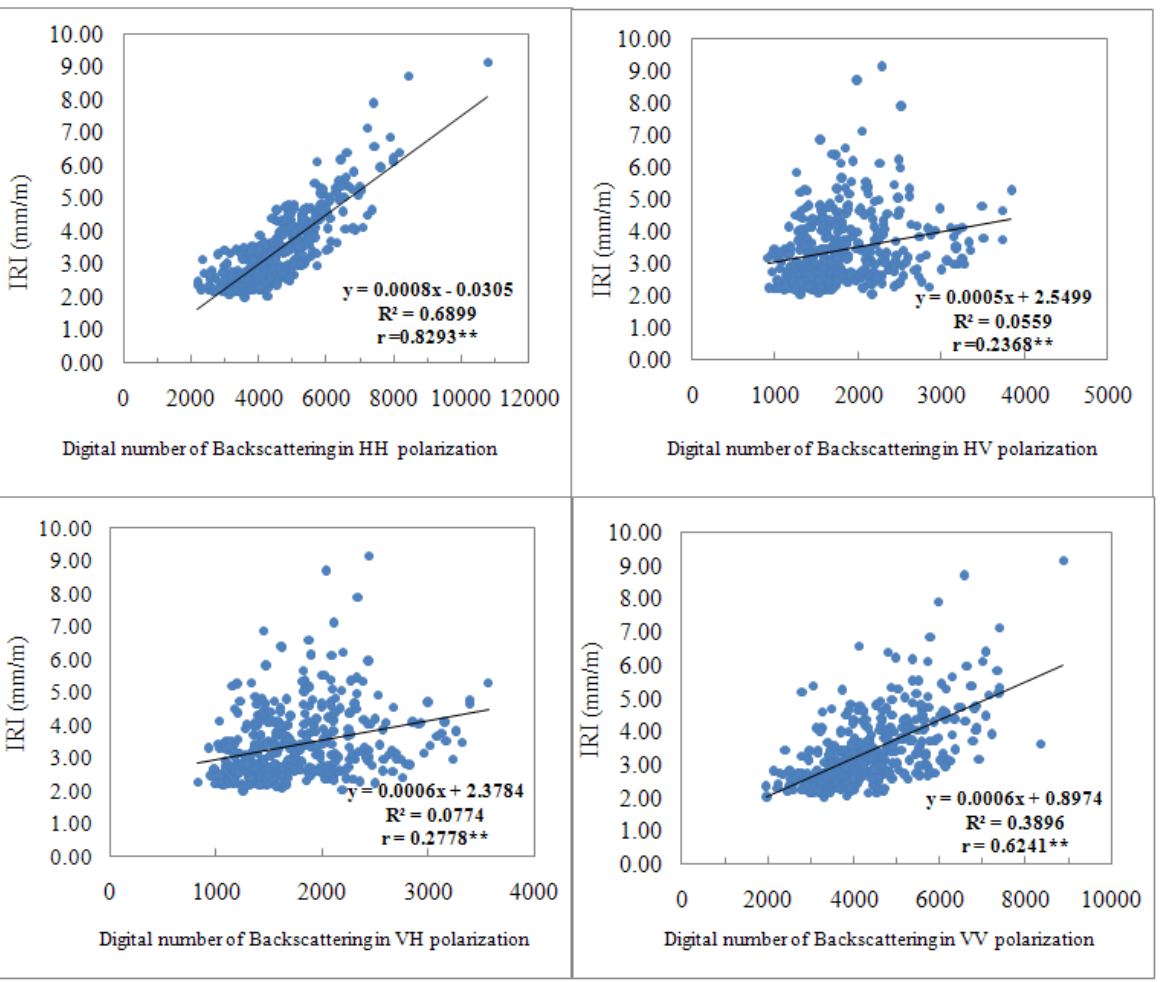
data: HH (top left), HV (top right), VH (bottom left) and VV (bottom right). Note: ** = correlation significant at the 0.01 level (two-tailed